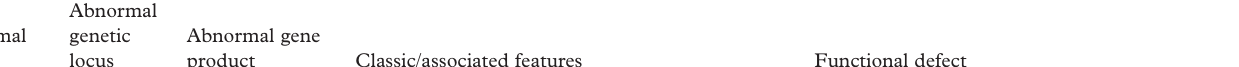
Table VI. Complement pathway